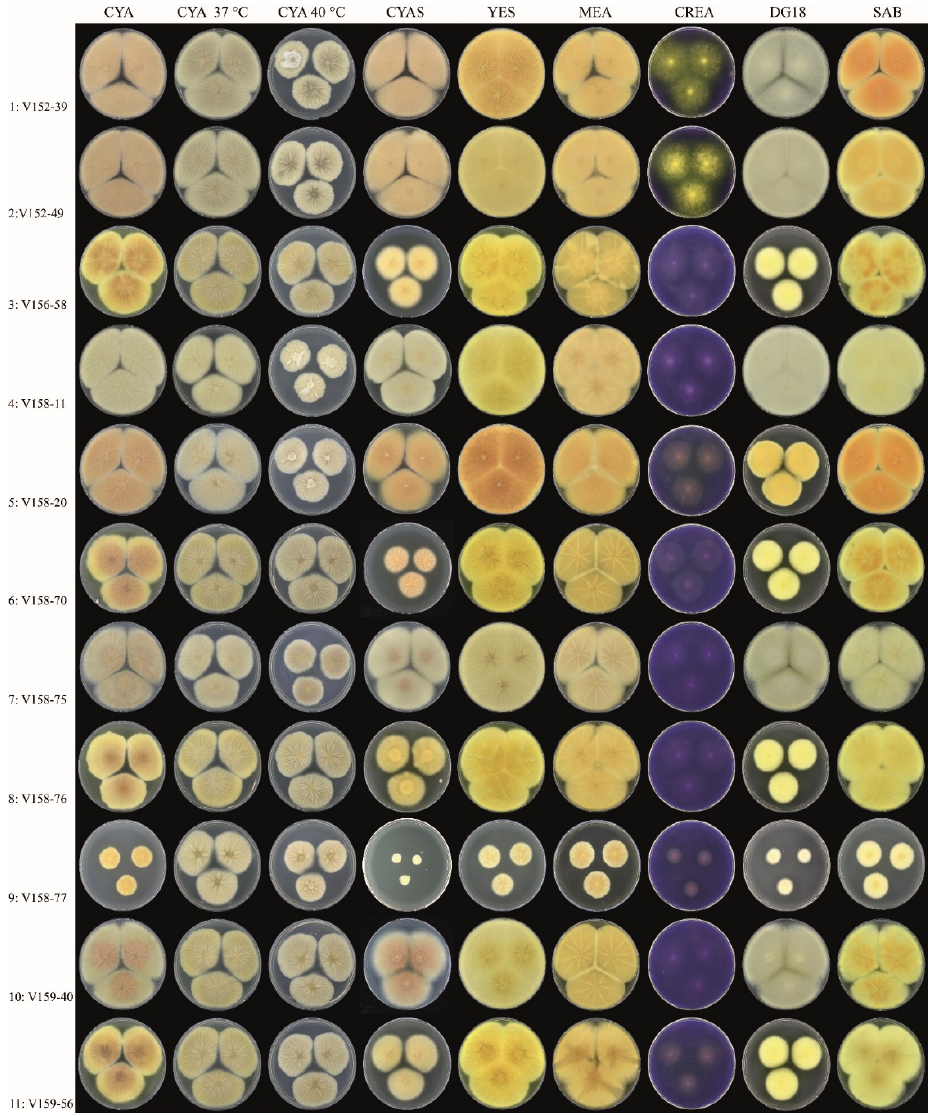
Figure A1. Overview of the phenotypic diversity of A. flavus isolates (all reverse, 7 days at 25 °C, unless stated otherwise). Columns, left to right: CYA, CYA incubated 37 °C, CYA incubated 40 °C, CYAS, YES, MEA, CREA, DG18, SAB. Rows, top to bottom: Isolates 1–11.